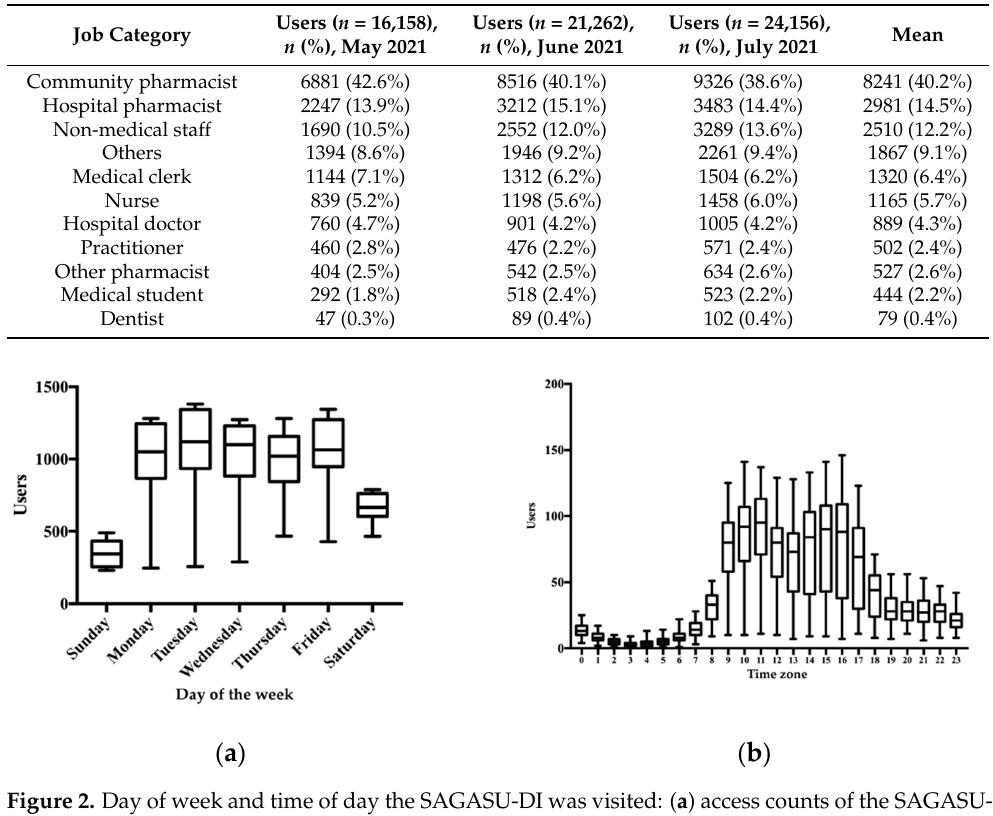
Table 3. Job category of SAGASU-DI users.